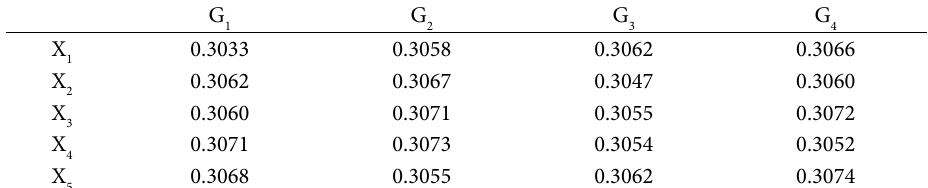
Table 9. Weight matrix (3) η